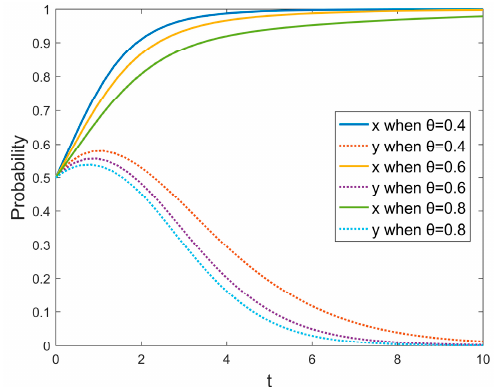
Figure 6. The impact of the government’s industrial support cost for the livelihood differentiation of herders in the evolutionary game